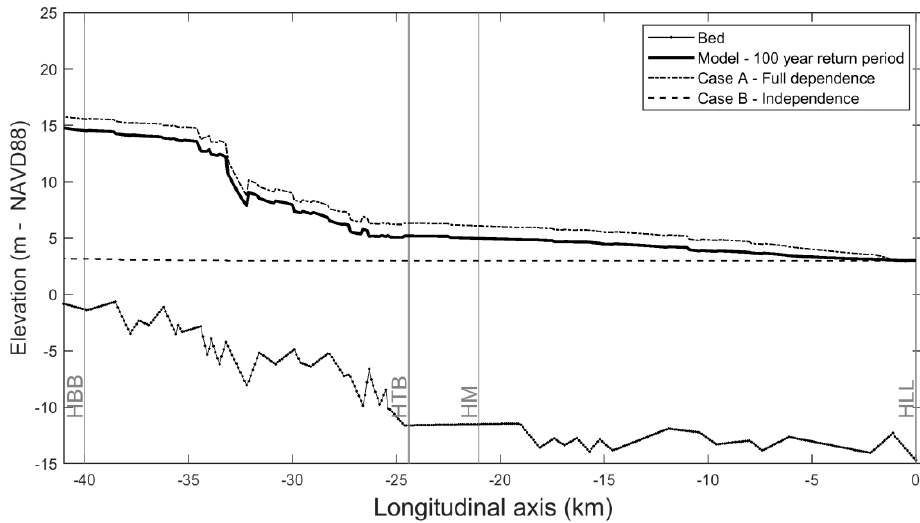
Figure 6. Sensitivity of the multivariate dependence assumptions. The 100–year water level obtained from the current model framework is represented by the black full line. Case A and B represent full dependence and ‘independence’ of the boundary conditions, respectively (see text).